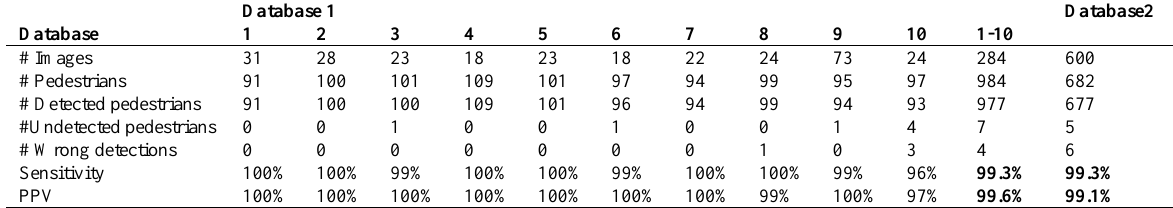
Table 6. Result of proposed method on databases 1 and 2.